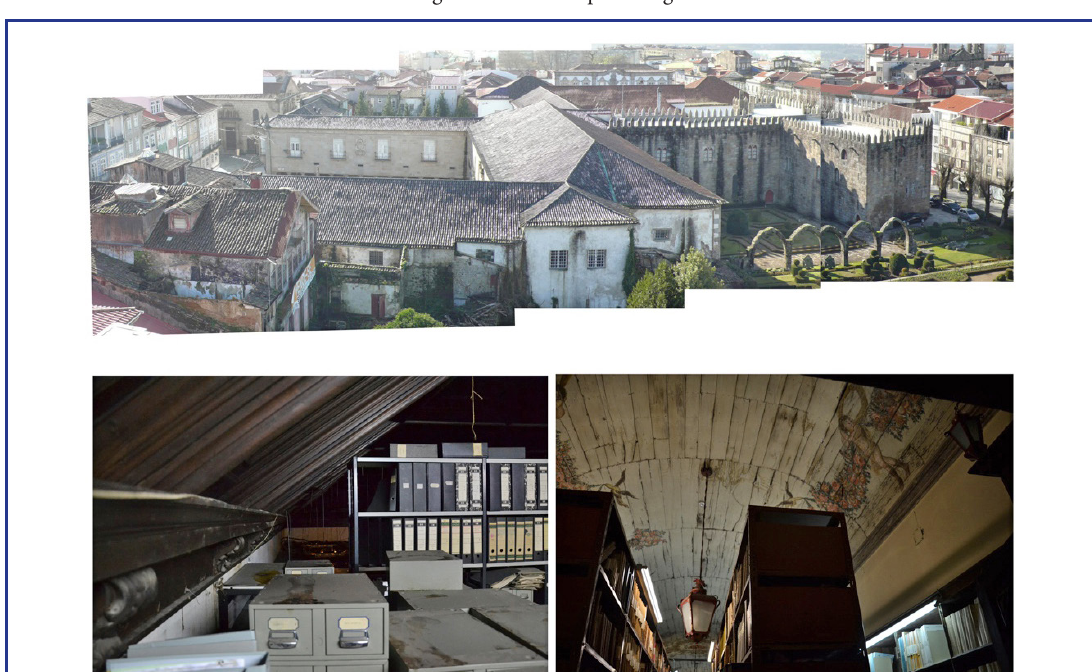
buildingFigure 5. Existent spatial